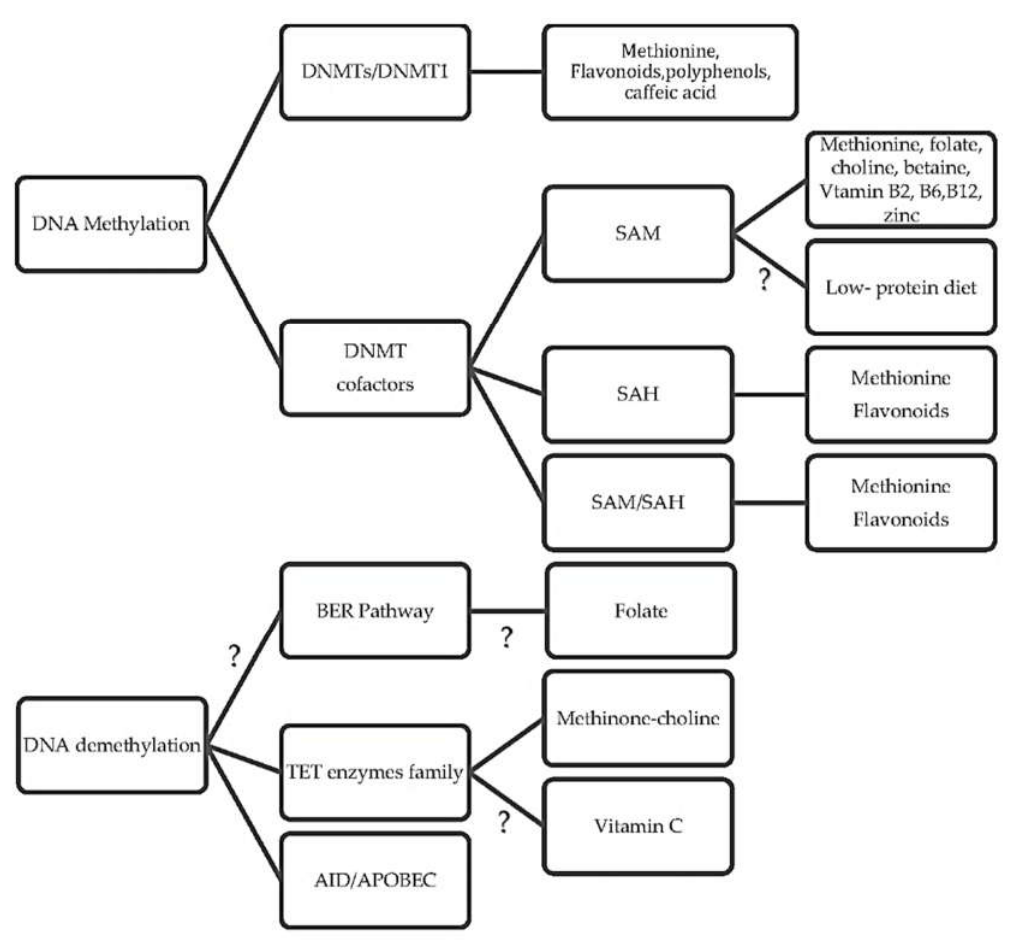
Figure 3. The possible mechanisms that nutrition can stimulate patterns of DNA methylation.